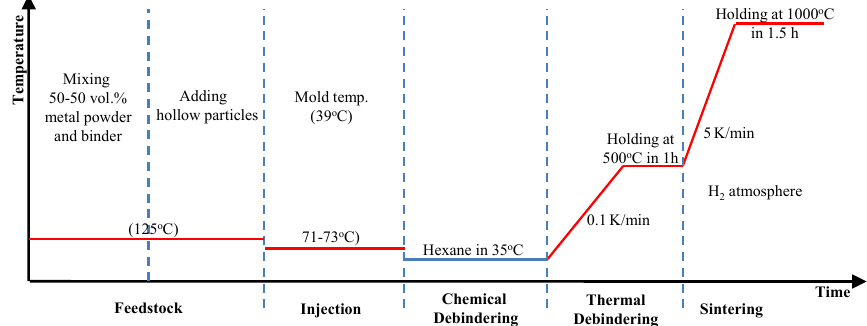
Figure 16. The metal powder injection molding (MIM) process of Invar SFs.